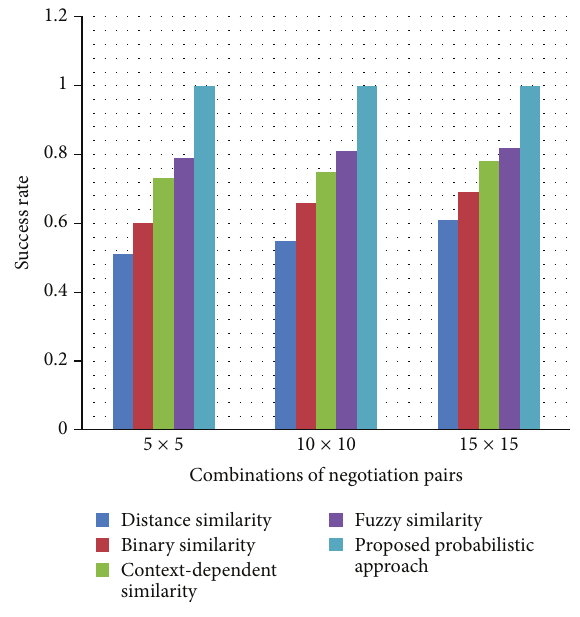
Figure 5: Achievement of success rate optimality.